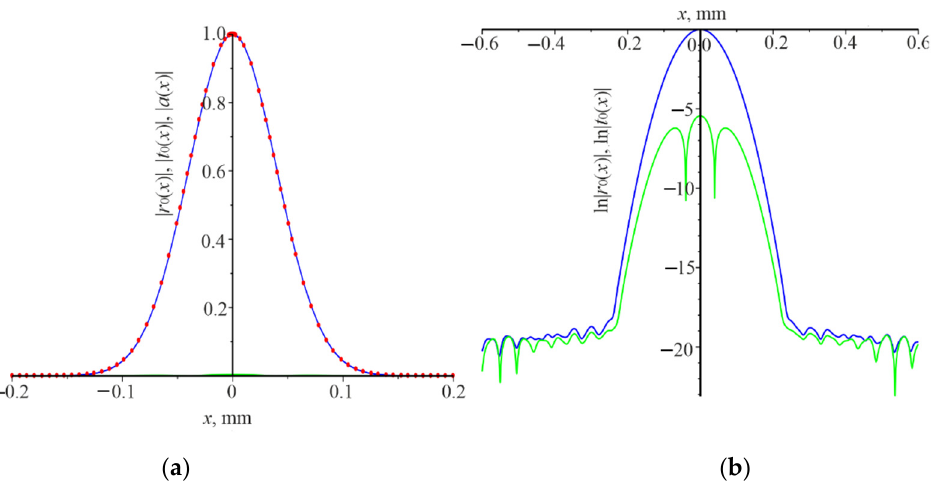
Figure 4. The distribution of the field amplitude along the x coordinate of the incident Gaussian beam | a ( x )| (red dots), reflected beam | r 0 ( x )| (blue curve), the transmitted beam | t 0 ( x )| (green curve) ( a ). ln| r 0 ( x )| (blue curve), ln| t 0 ( x )| (green curve) ( b ). Numerical calculations were carried out under the conditions 𝑑 = 0.32 μm,𝜆 = 1.03 μm, 𝜃 = 0, 𝐿 = 0.1 mm .